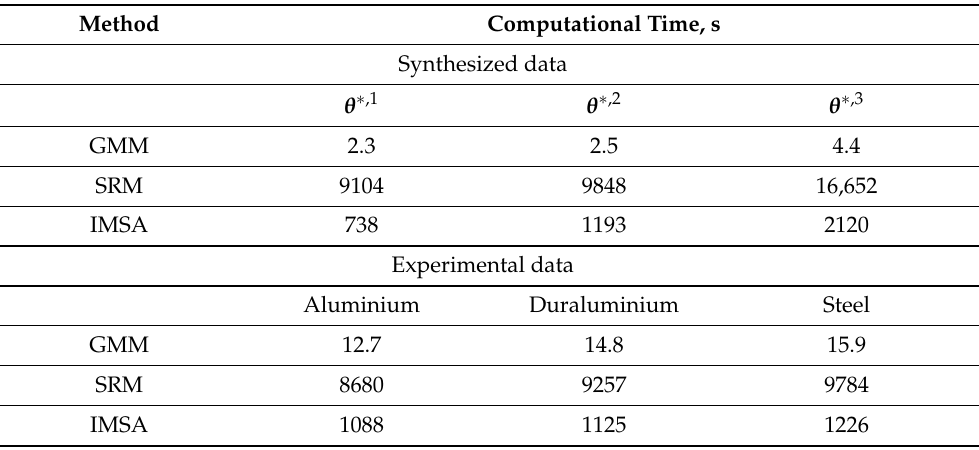
Table 1. The average computational time (in seconds) for the three methods applied to the synthesized and the experimental